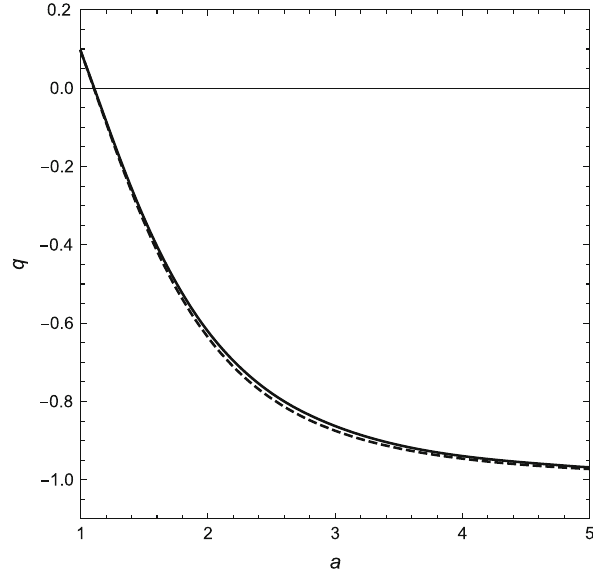
Fig. 1 Qualitative evolution of the deceleration parameter q ( a ) , for the vacuum model (13) for w 1 = 0. Solid line is for n = 3 and λ 2 = 1, whiledashedlineisfor n = 1and λ 2 = λ B of the deceleration parameter is similar for all the positive values of λ 2 and n . For the initial conditions of the numerical simulation we selected a ( t 0 ) = 1, ˙ a ( t 0 ) = 70 and (cid:9) m 0 (cid:6) 0 .